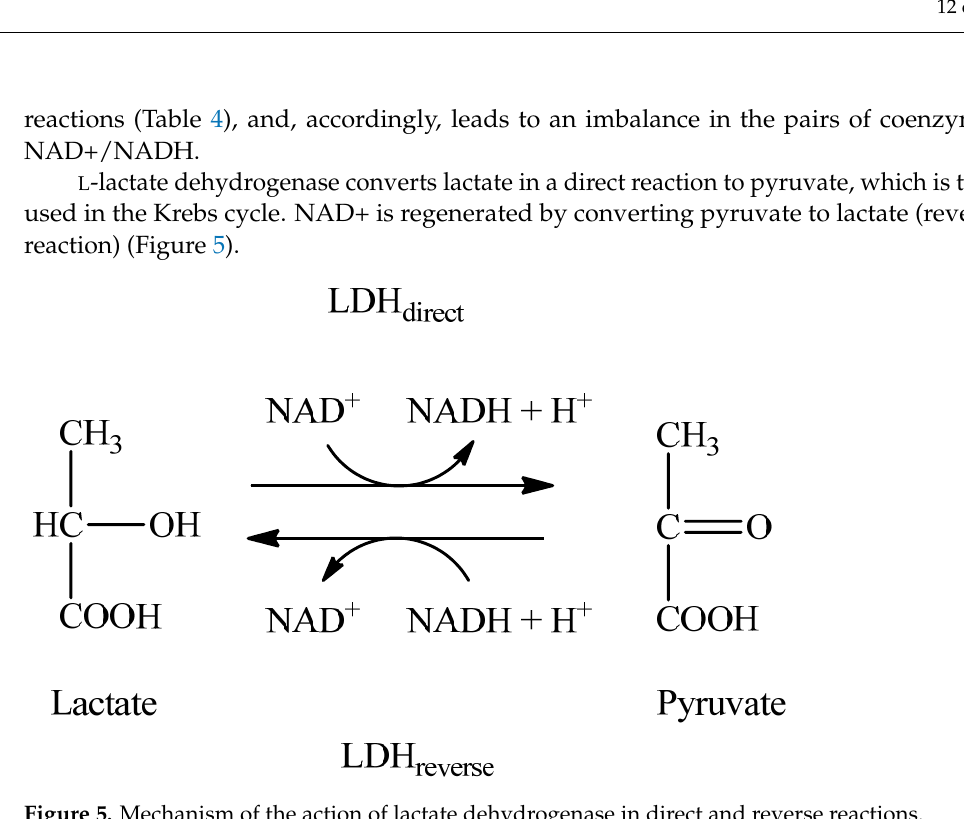
Figure 5. Mechanism of the action of lactate dehydrogenase in direct and reverse reactions.